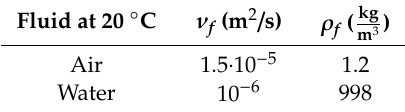
Table 1. Fluid properties at atmospheric